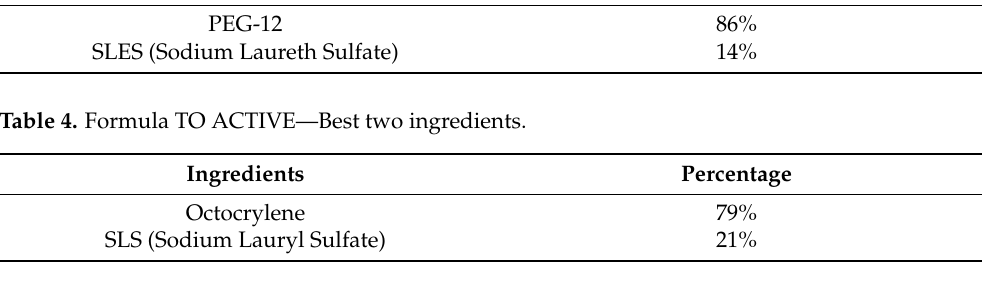
Table 5. Formula TO SKIN—Best three ingredients.